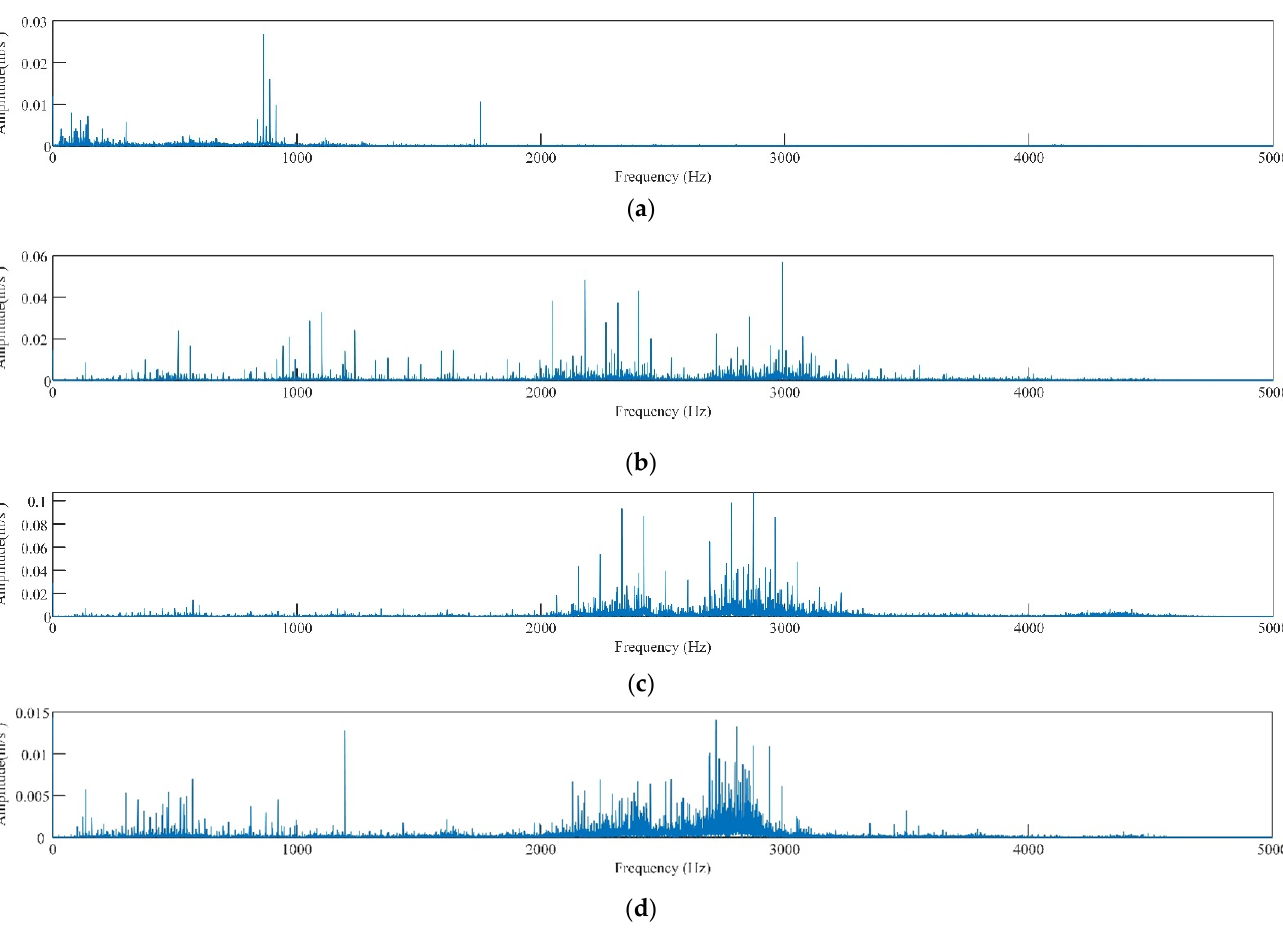
Figure 7. Frequency domain diagram of rolling bearing vibration signals of different fault types, ( a ) normal, ( b ) inner ring damaged, ( c ) outer ring damaged, ( d ) rolling body damaged.